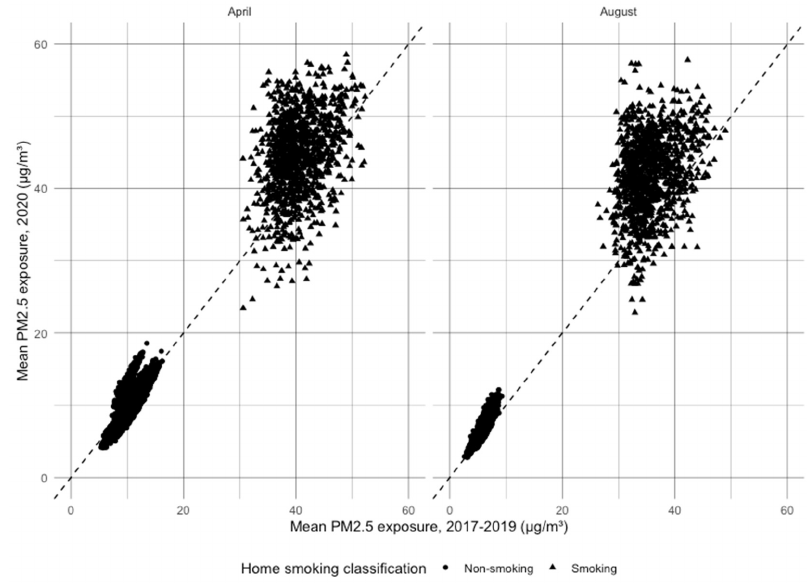
Figure 1. Mean modelled exposure during the months of April and August 2017–2019 vs. the same months for 2020 by participant. The group of points to the upper right ( n = 1120) represent modelled individuals living in smoking homes, while those in the lower left are for those living in smoke ‐ free homes ( n = 8880). Dashed line represents identity (y = x, i.e., the personal exposure during lockdown was the same as during 2017–2019). Points to the left of the dashed line indicate an increase during lockdown. Median modelled exposure declined from 11.1 μ g/m 3 to 10.8 μ g/m 3 between April 2017–19 and April 2020 (median difference: − 0.6 (IQR: − 1.28–0.406)), but increased from 6.1 μ g/m 3 in August 2017–2019 to 7.3 μ g/m 3 in August 2020 (median difference: +1.23 (IQR: 0.572–1.94)).